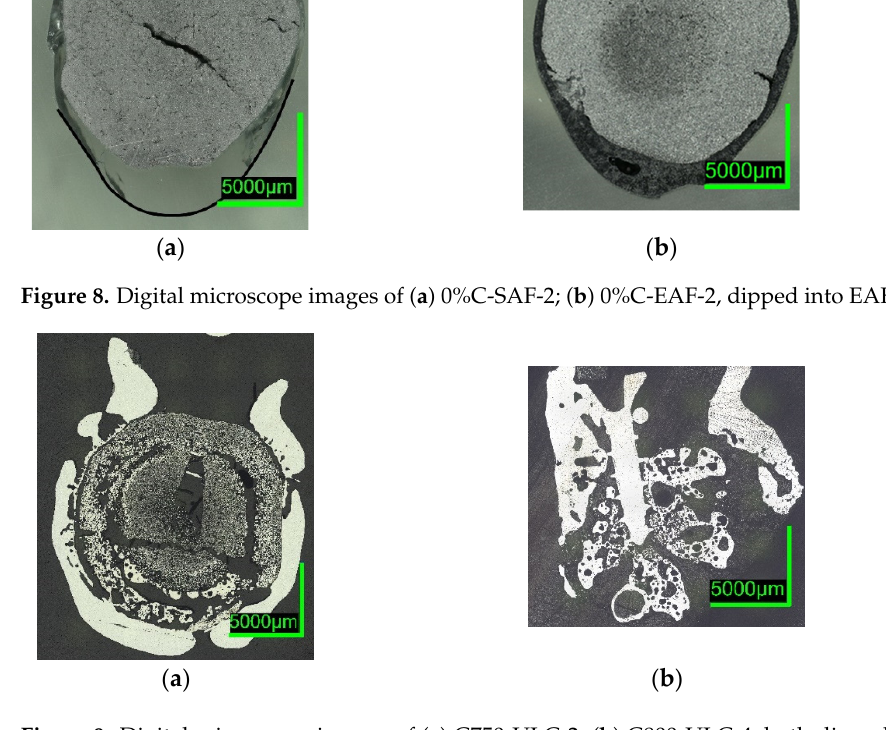
Figure 9. Digital microscope images of ( a ) C750-ULC-2; ( b ) C800-ULC-4, both dipped into liquid ULC steel.